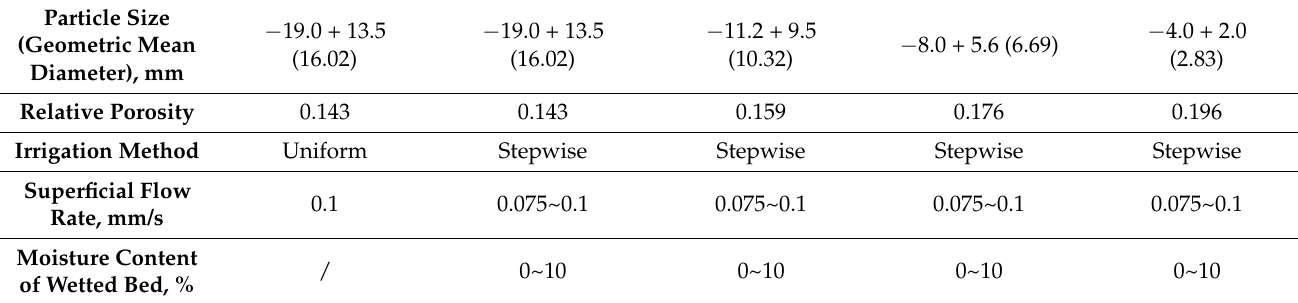
Table 2. Experimental design under different irrigation and heap porosity